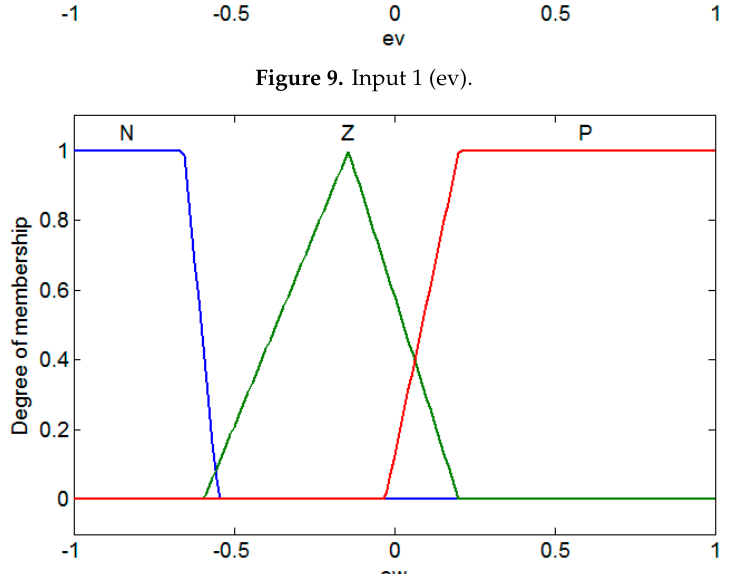
Figure 9. Input 1 (ev).